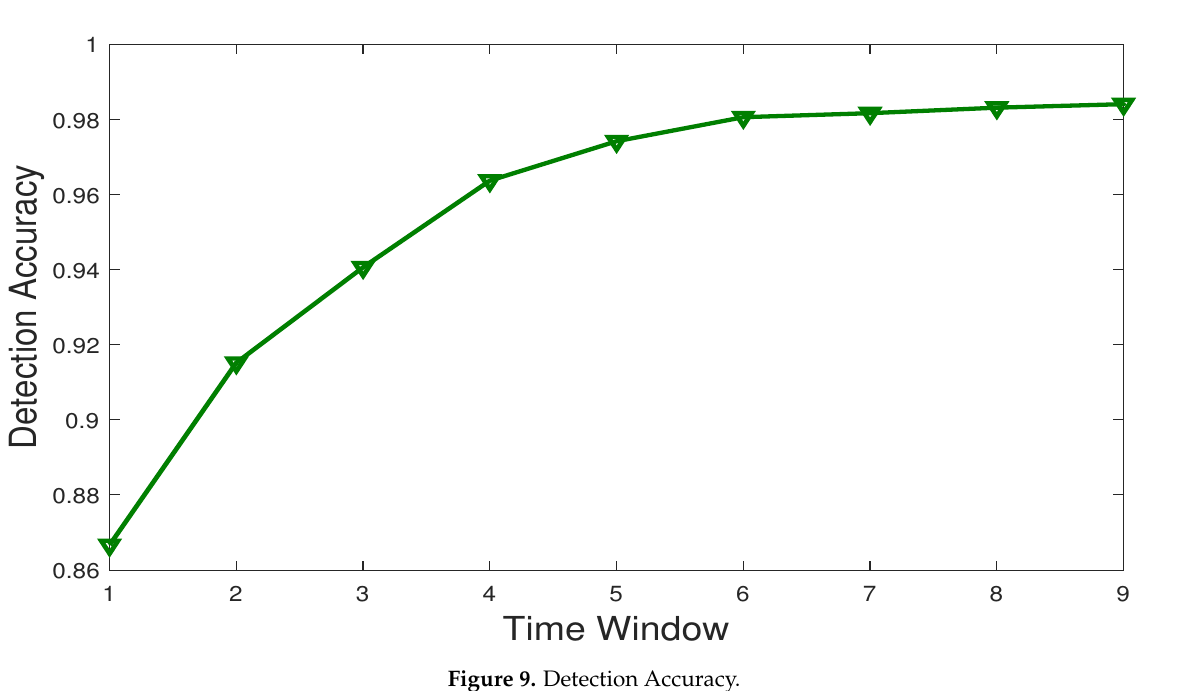
Figure 9. Detection